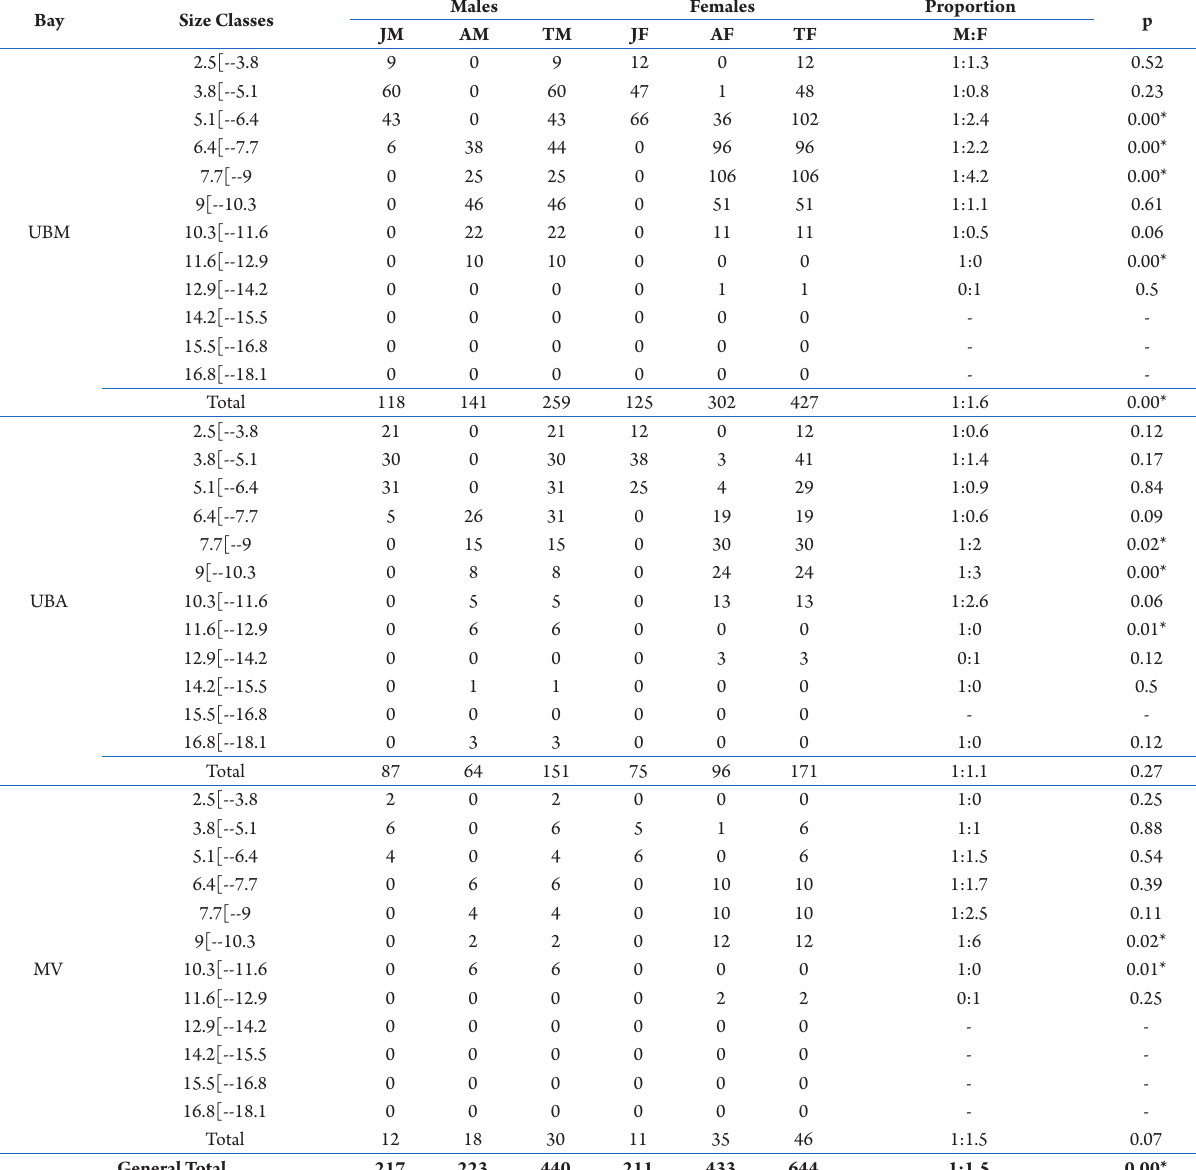
Table 2. Hexapanopeus paulensis. Frequency distribution of demographic groups in size-classes with binomial test results for sex ratio. Bay Size Classes